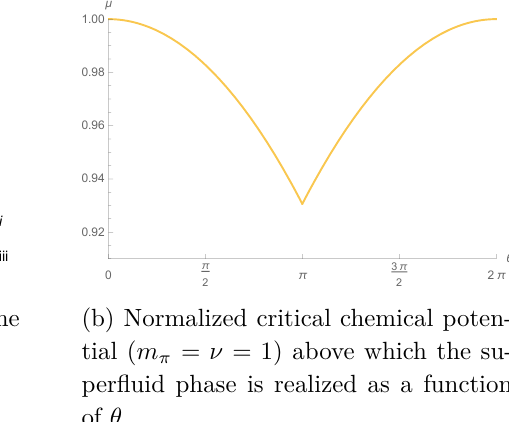
tion of θ in the normal phase. Figure 5 . θ -dependence of the CP order parameter for N f = 3 .